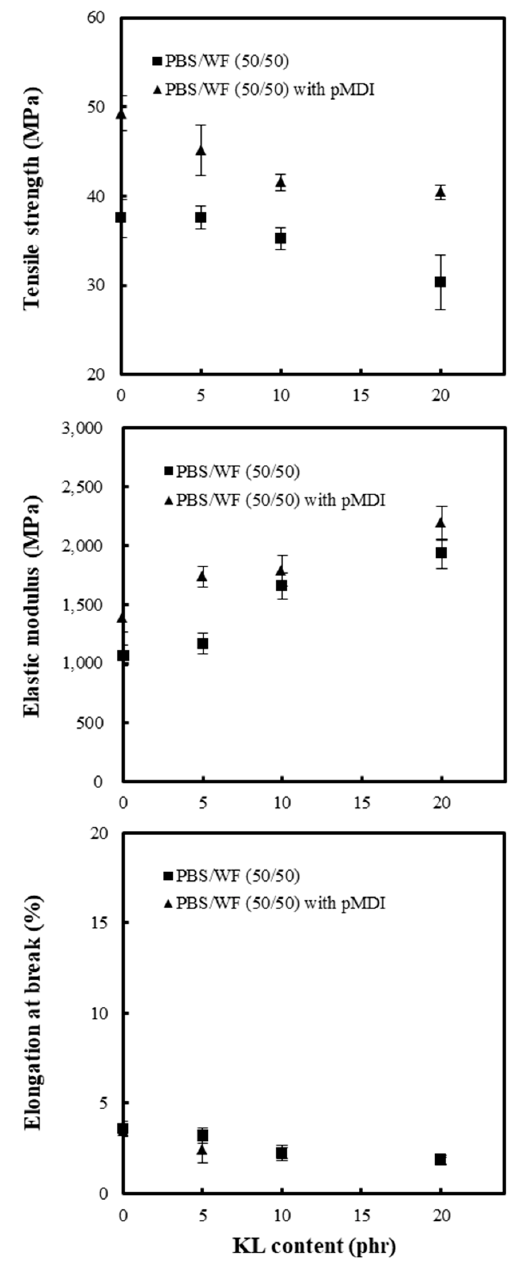
Figure 5. Tensile strength, elastic modulus, and elongation at break of PBS/WF/KL composites with and without pMDI (2phr).